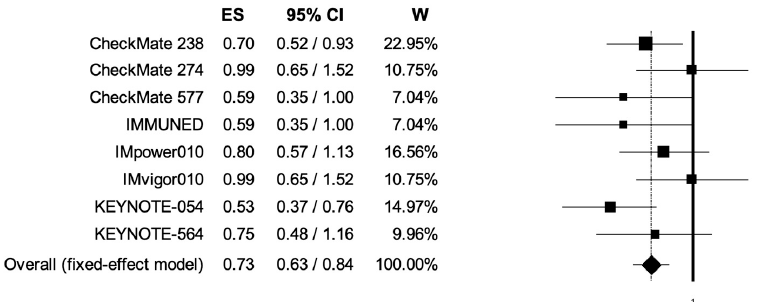
Figure 5. Forest plot of comparison between adjuvant PD-1 and PD-L1 inhibitors versus control (placebo/ipilimumab/observation/best supportive care) in cancer patients; the outcome of interest was relapse-free survival (RFS) in female patients. Abbreviations: CI: confidence interval; ES: effect size; and W: weight.